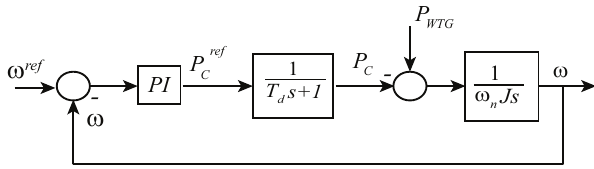
Figure 7. Frequency control with the synchronous condenser.